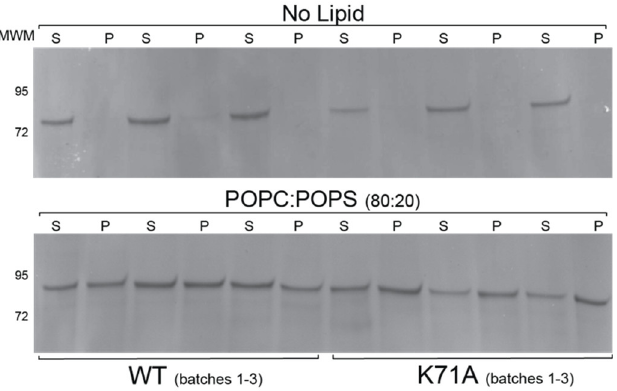
Figure 5. The K71A mutation binds to liposomes containing phosphatidylserine higher than the wild-type HspA1A. In these experiments, a single concentration of liposomes (1 mM total lipid) was used composed of POPC:POPS (80:20 mol:mol) incubated with 1 μM of protein. SDS-PAGE gel electrophoresis of the supernatant (S) and pellet (P) fractions of wild-type and K71A HspA1A without liposomes (Top; negative control) and with liposomes composed of POPC:POPS (80:20 mol:mol).